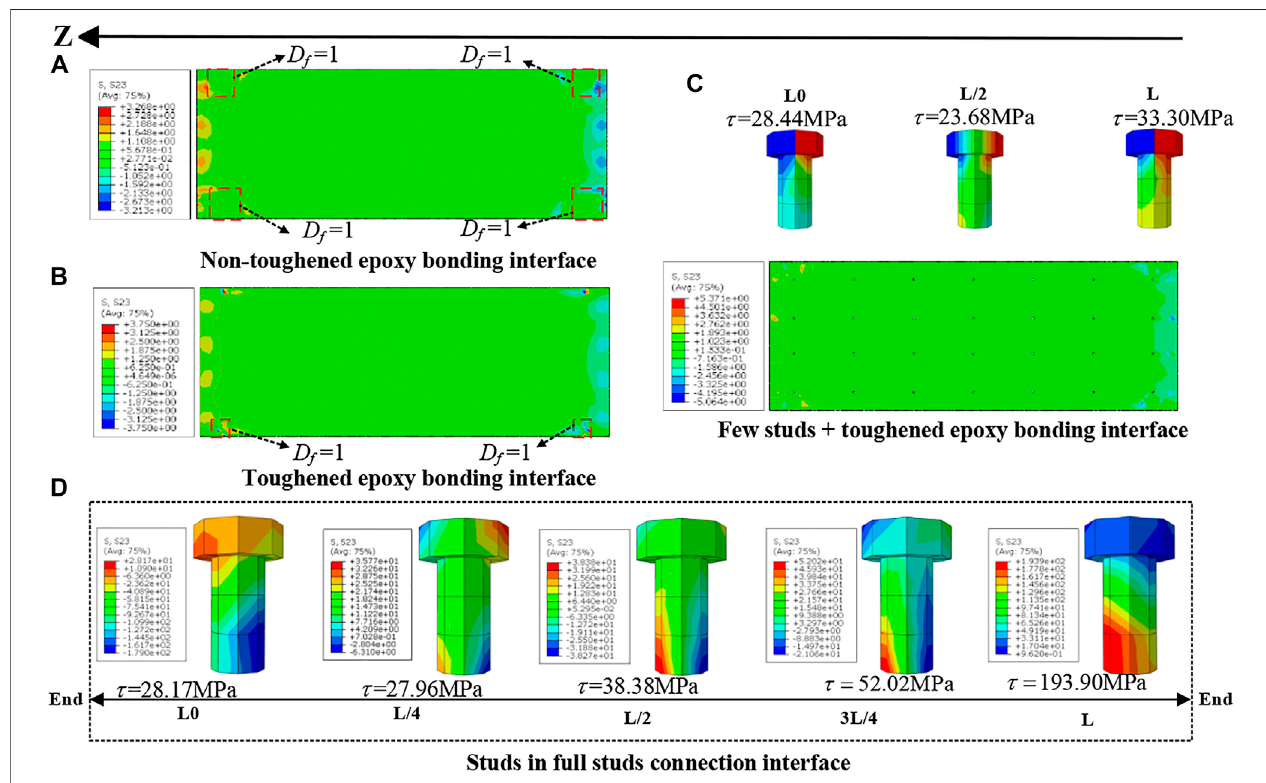
FIGURE 13 | Interface stress distribution under UHPC shrinkage. (A) Non-toughened epoxy bonding interface. (B) Toughened epoxy bonding interface. (C) Few studs + toughened epoxy bonding interface. (D) Studs in the full stud connection interface.